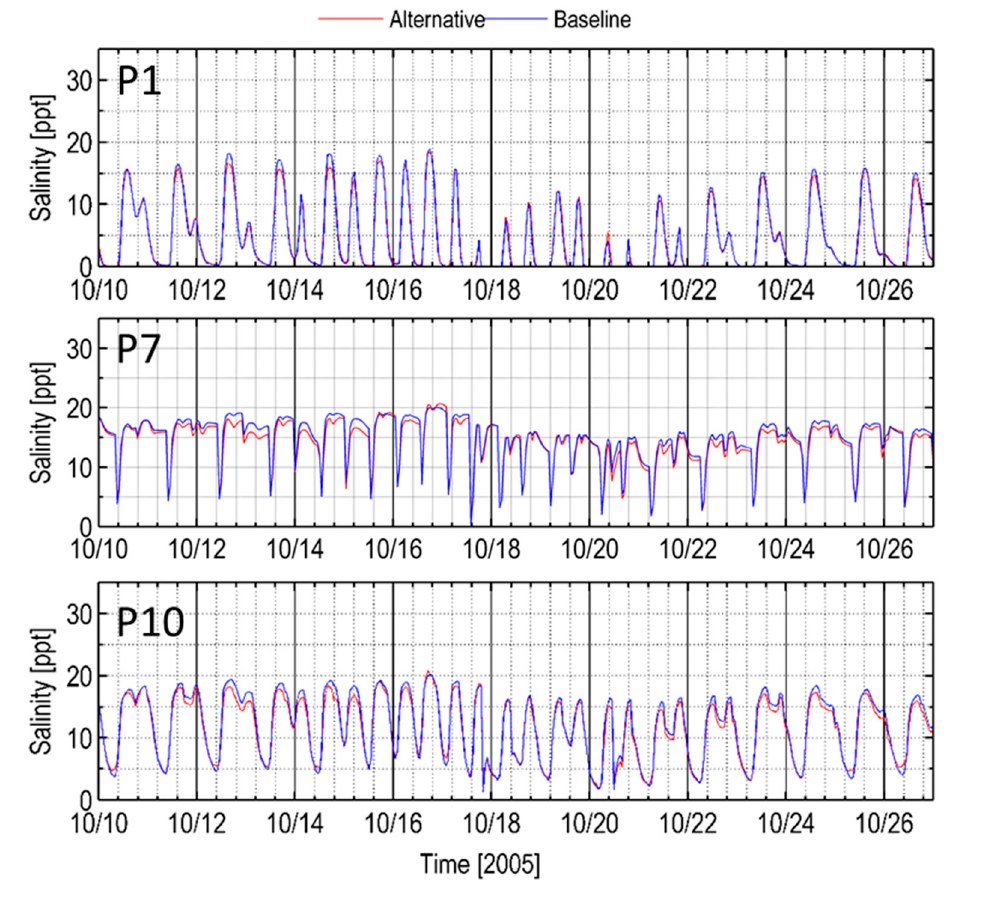
Figure 11. Preferred vs. baseline scenarios: time series of Salinity at Station P1, P7, and P10 for typical estuarine conditions (October 2005).